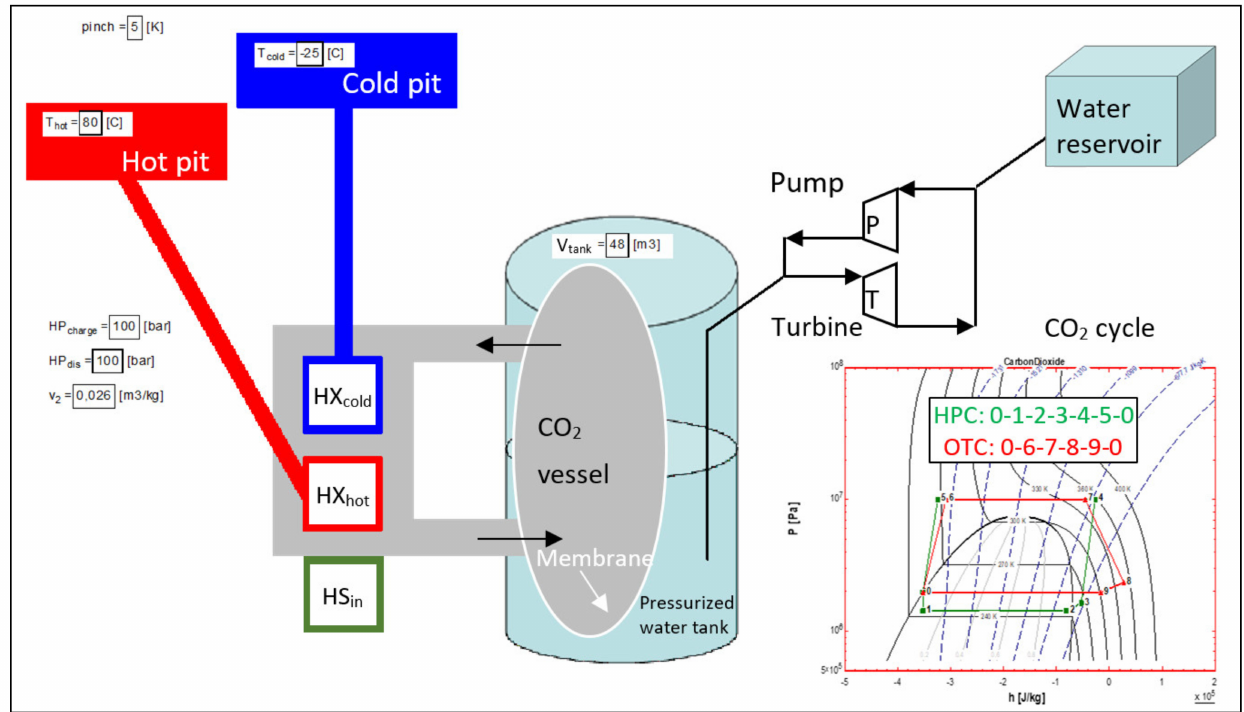
Figure 2. Scheme of the system in the EES